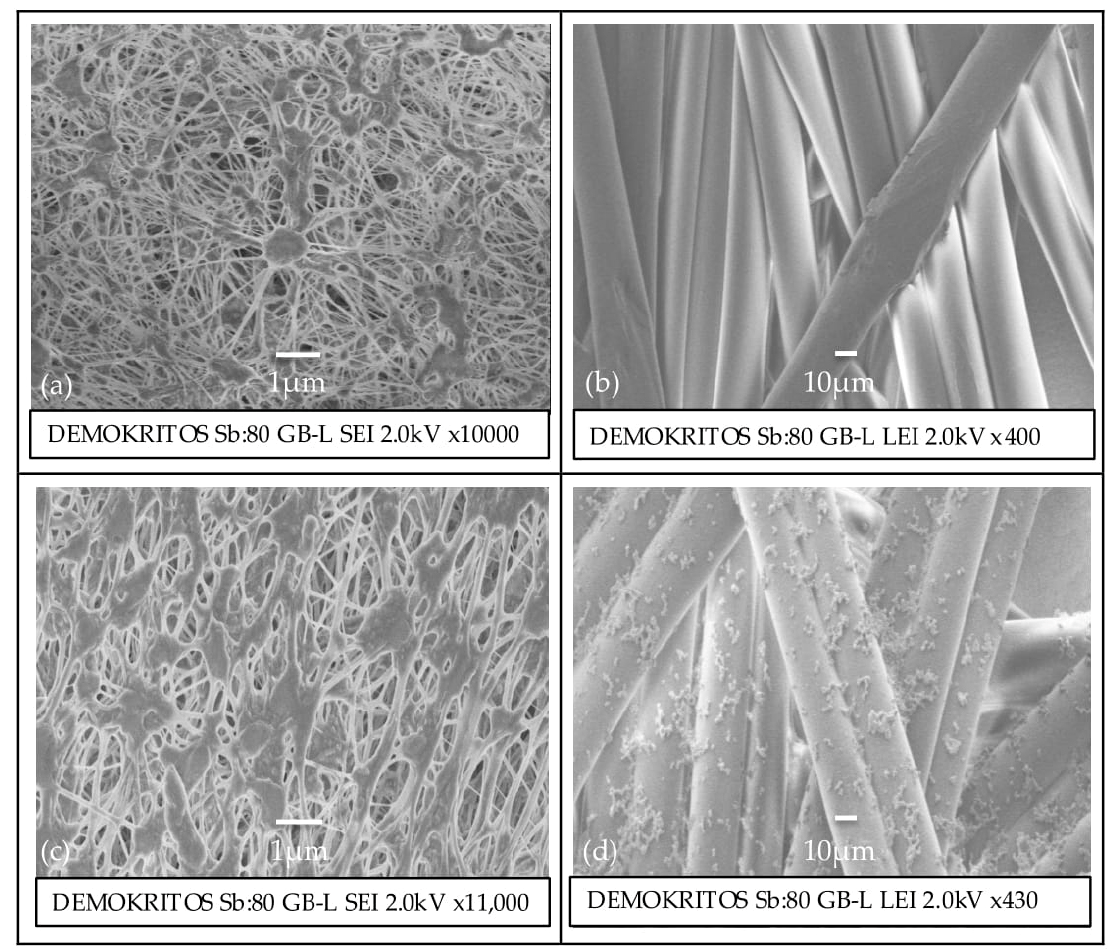
Figure 4. SEM images of pristine membrane surface of the feed side ( a ) and permeate side ( b ); SEM images of PTFE-1.0 surface of feed side ( c ) and permeate side ( d ).